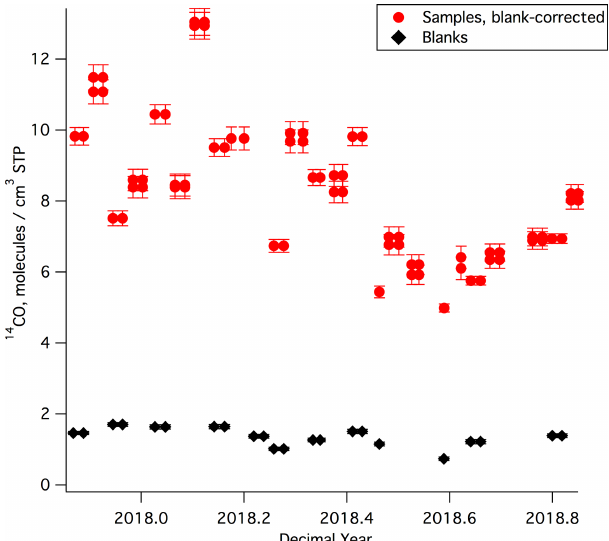
Figure 3. [ 14 CO] results for all MLO samples and blanks. Most samples and blanks were collected by half filling the canisters on two separate days. To illustrate this, [ 14 CO] values for these sam- ples and blanks are plotted for each of these dates, appearing twice as adjacent data points. All shown [ 14 CO] uncertainties are 1 σ . We observed a correlation for sample–blank pairs collected on the same day. This correlation is not due to analytical artifacts and is dis- cussed in detail in the